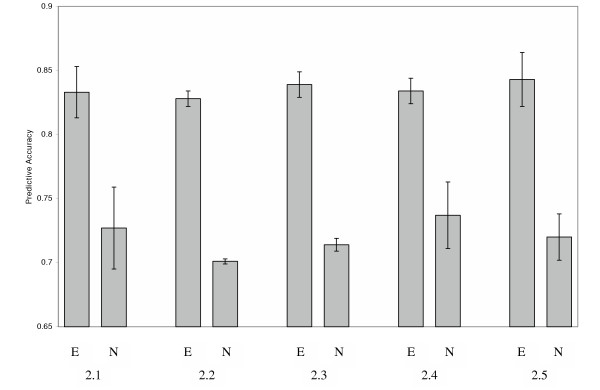
Maximum predictive accuracy of OGA Chromosomes on the generalization set in Experiment 2. Mean ± standard deviations are shown for the five replicates of the experimental (E) and negative control (N) runs for the five data sets (2.1 to 2.5) used.